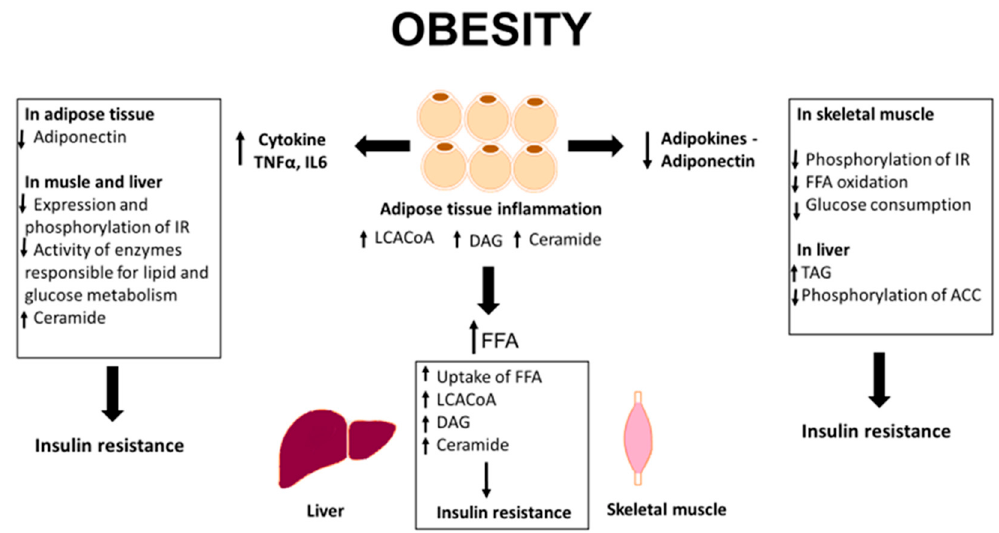
Figure 1. Overview of adipocytes dysfunction in obesity. IR, insulin receptor; FFA, free fatty acids; TAG, triacylglycerols; ACC, acetyl-CoA carboxylase, TNF- α , tumor necrosis factor α ; IL6, interleukin 6; LCACoA, long chain acyl-CoA; DAG, diacylglycerols.